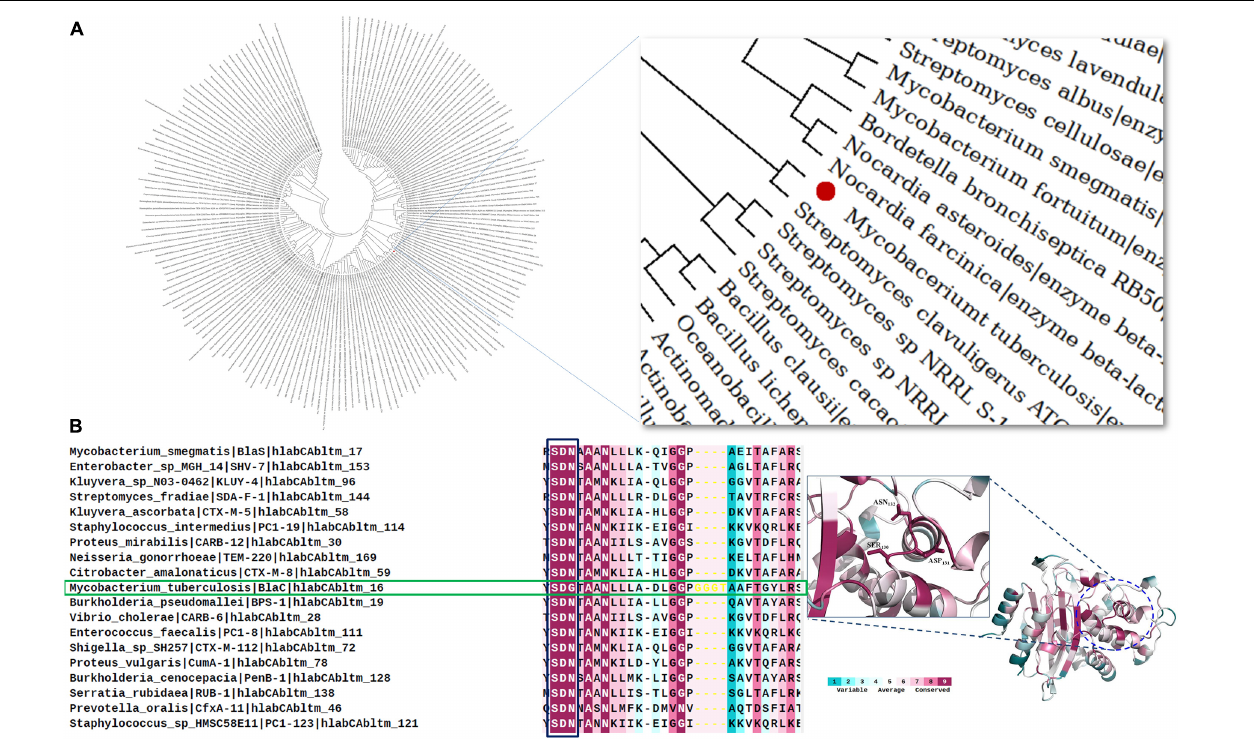
FIGURE 1 | Evolutionary and conservation analyses of BlaC beta-lactamase. (A) Relatedness of BlaC beta-lactamase from Mycobacterium tuberculosis (highlighted in the red sphere) with class A beta-lactamase from other species. (B) Conservation analysis of SDN loop in different class A beta-lactamases. M. tuberculosis (green box) has an SDG loop instead of an SDN